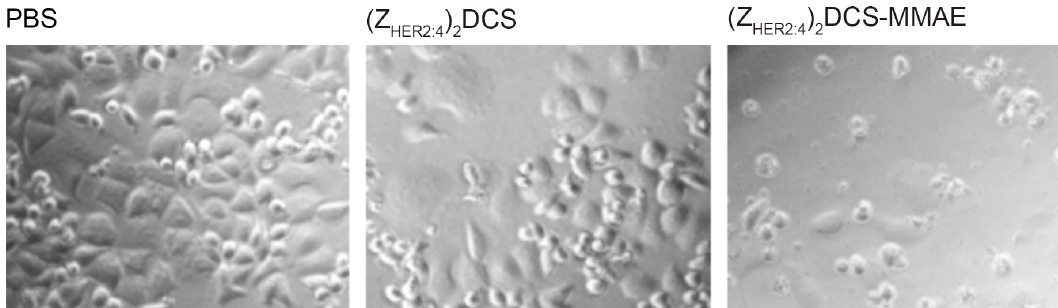
Figure 7. Microscopic analysis of SK-BR-3 cells treated with phosphate buffer saline (PBS), 500 nM (Z HER2:4 ) 2 DCS, and 500 nM (Z HER2:4 ) 2 DCS-MMAE after 72 h. The cells incubated with the anti-HER2 diaffibody did not show any morphological changes in comparison to the untreated control cells, whereas the viability of the cells treated with the conjugate was severely affected.